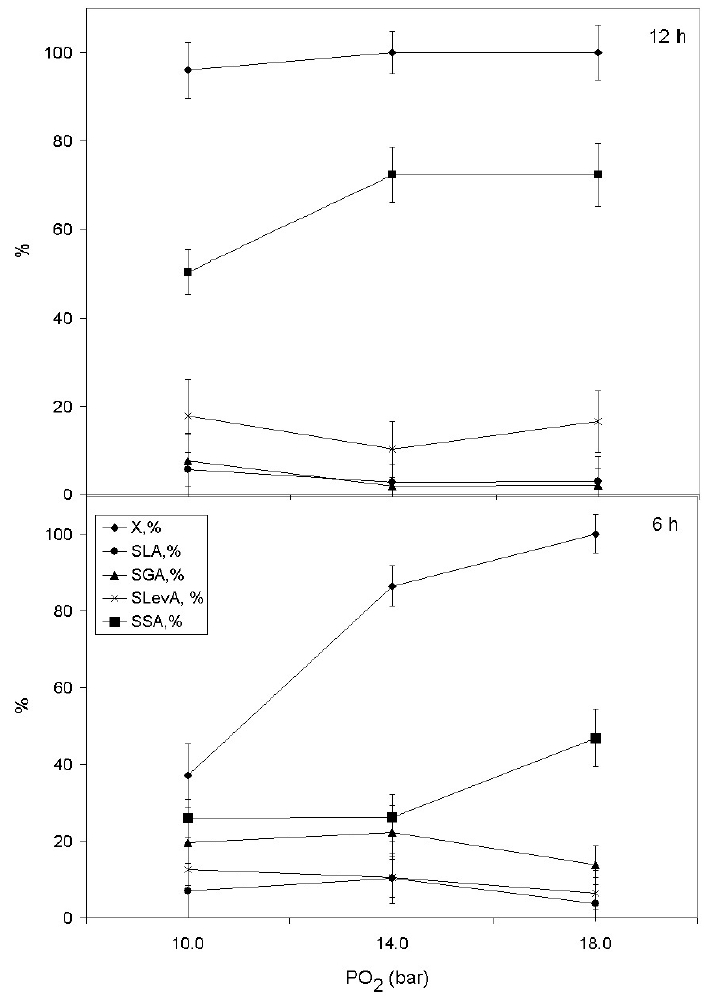
Figure 8. The influence of the oxygen pressure and reaction time upon the reaction product distribution (Reaction conditions: 90 mg glucose; 50 mg Nb(0.05)- β 18 catalyst; 10 mL water, 180 °C . LA—lactic acid; GA—glycolic acid, LevA—levulinic acid; SA—succinic acid). Note that the values from graph are averaged ± %RSD ( n = 3).